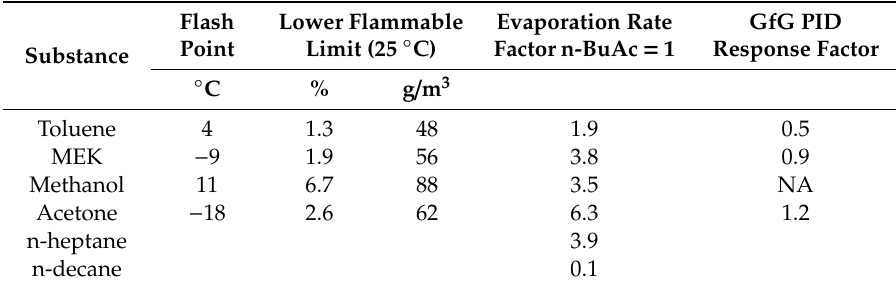
Table 2. Additional Information Concerning Lacquer